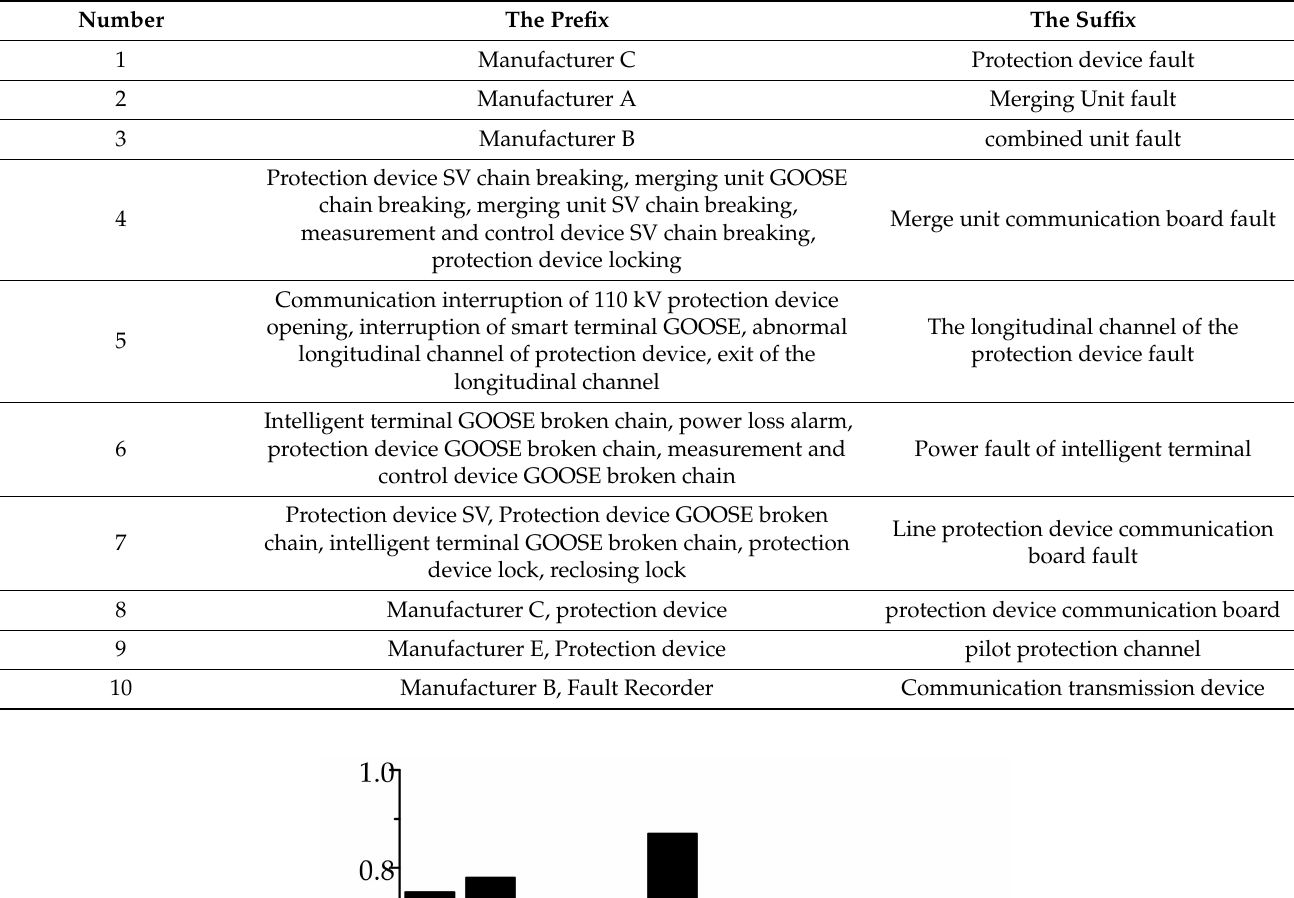
Table 3. Association rules.